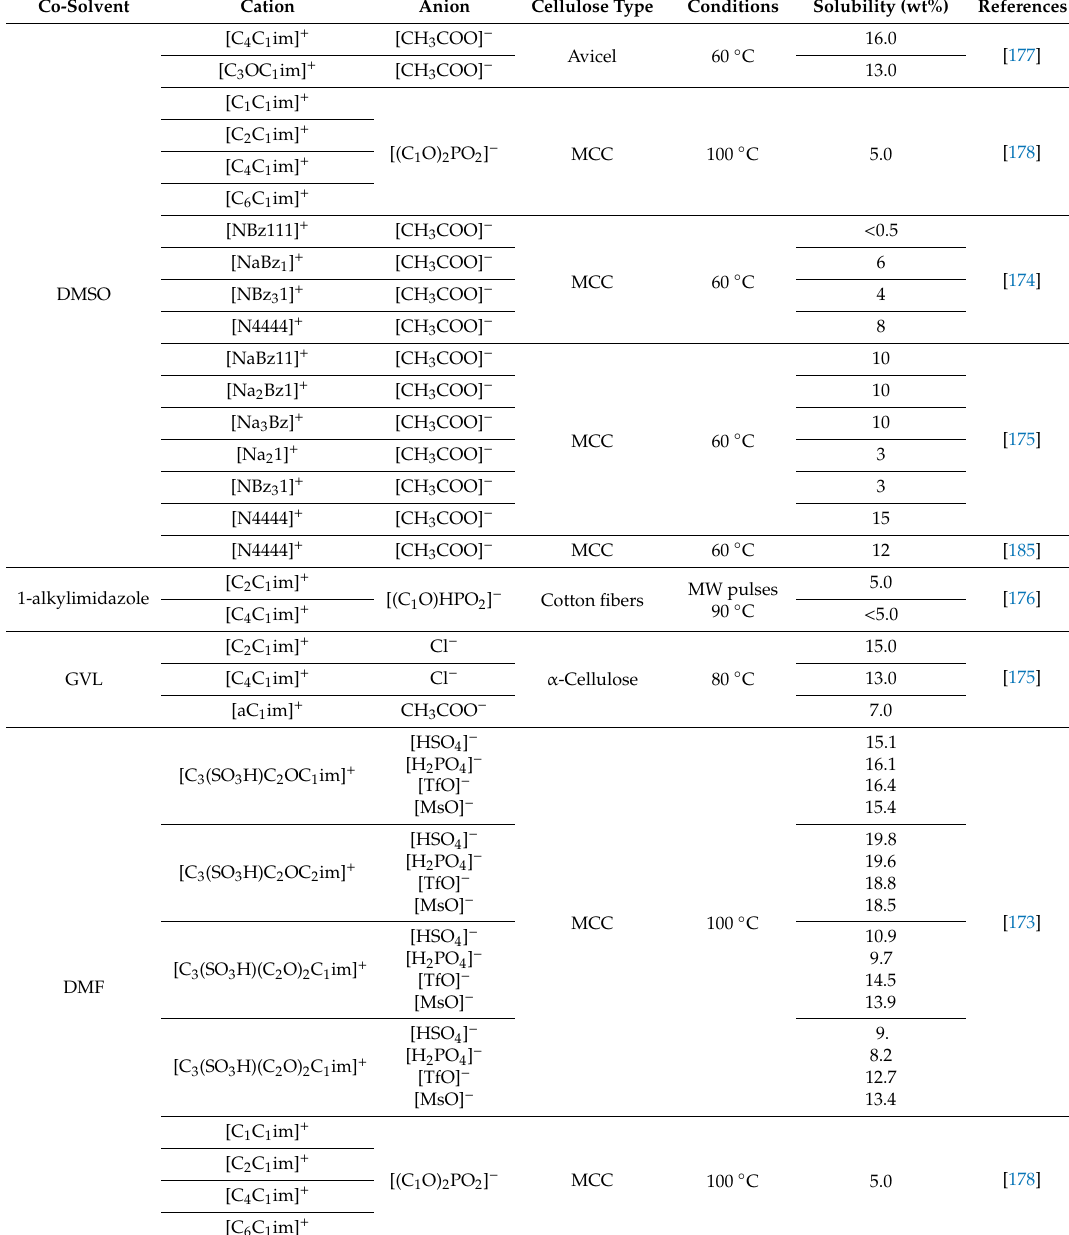
Table 5. MixturesofILs / co-solventsreportedtodissolvecellulose, cellulosesolubilityandconditionsapplied.